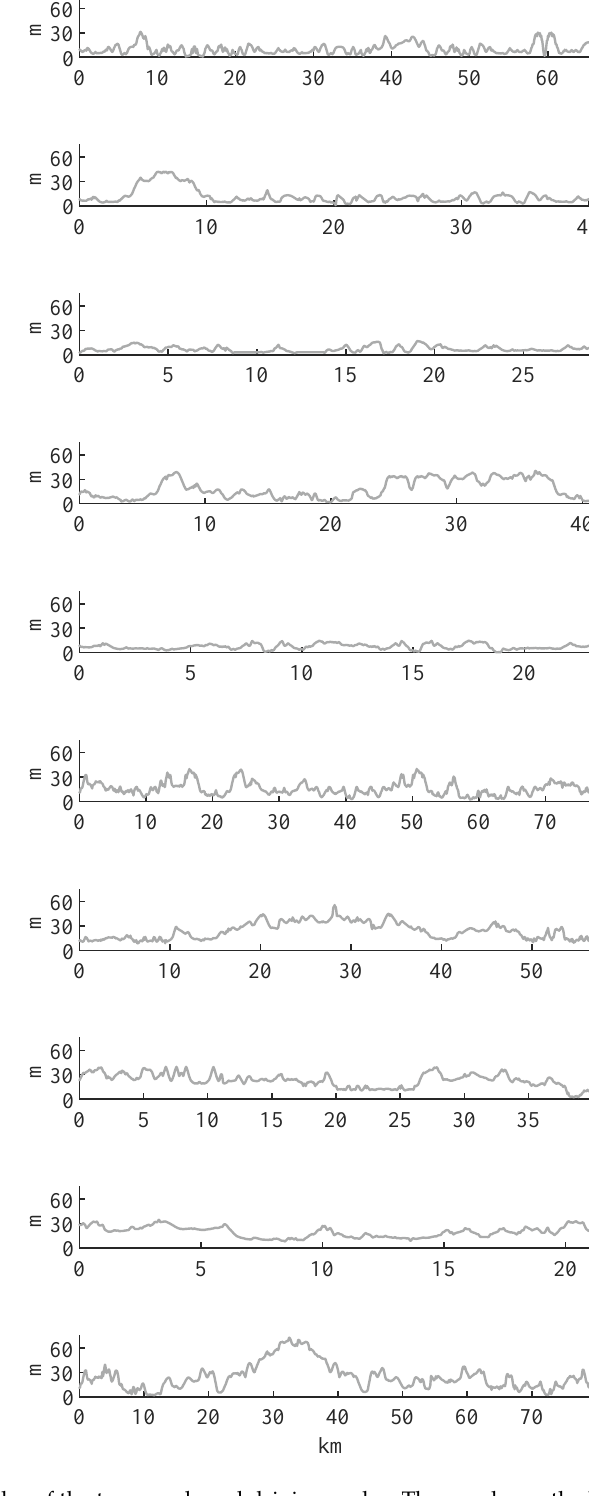
Figure 10. Speed profiles and altitudes of the ten map-based driving cycles. The graphs on the left show the speed profiles and the graphs on the right are the corresponding